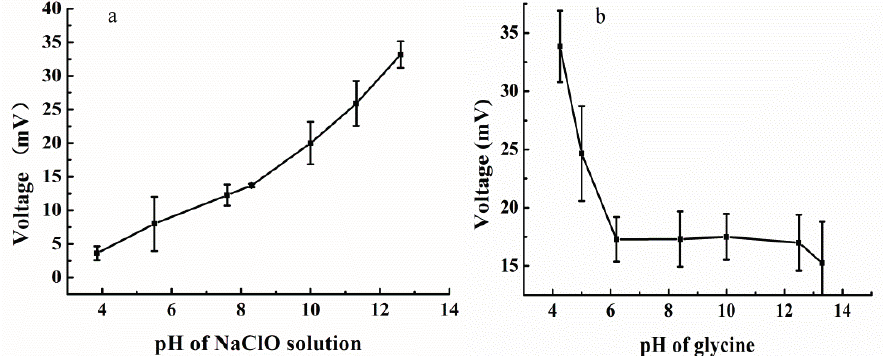
Figure 2. ( a ) Effect of pH of NaClO solution on the thermal sensor for a 350 μ L injection of 156.2 mg/L glycine solution, at a 1.0 mL/min flow rate and signal magnification of 100; ( b ) pH effect of the glycine solution in the thermal sensor when injecting 350 μ L of 156.2 mg/L glycine solution, at a 1.0 mL/min flow rate and signal magnification of